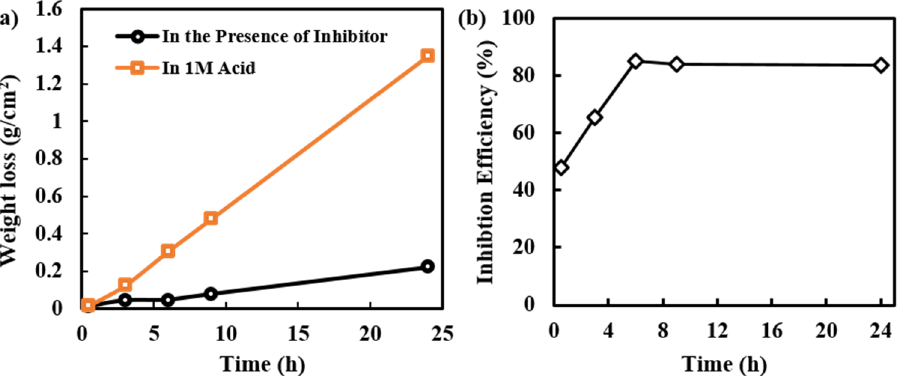
Figure 3. ( a ) Variation of weight loss of MS samples in acid and in the presence of inhibitor solution at different intervals of time, and ( b ) Inhibition efficiency of alkaloid solution at different intervals of time.